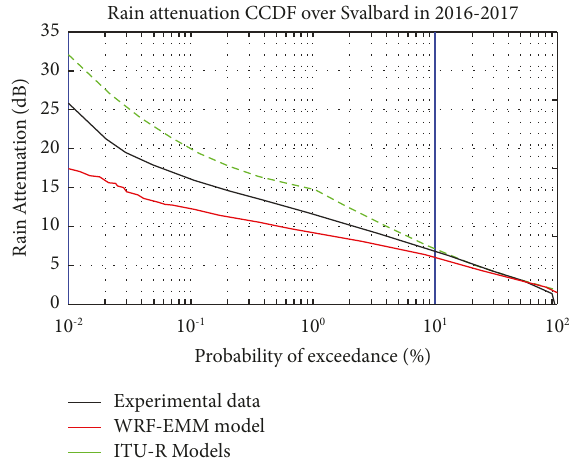
Figure 11: Comparisons between CCDFs of total attenuation computed from data measured in SvalSat in April 2016–March 17 (91.7% availability), WRF-EMM simulations and Rec. ITU-R P.618–13 using R 0.01 predicted with Rec. ITU-R P.837–7, as well as Recommendations ITU-R P.840–8 and P.676–11.